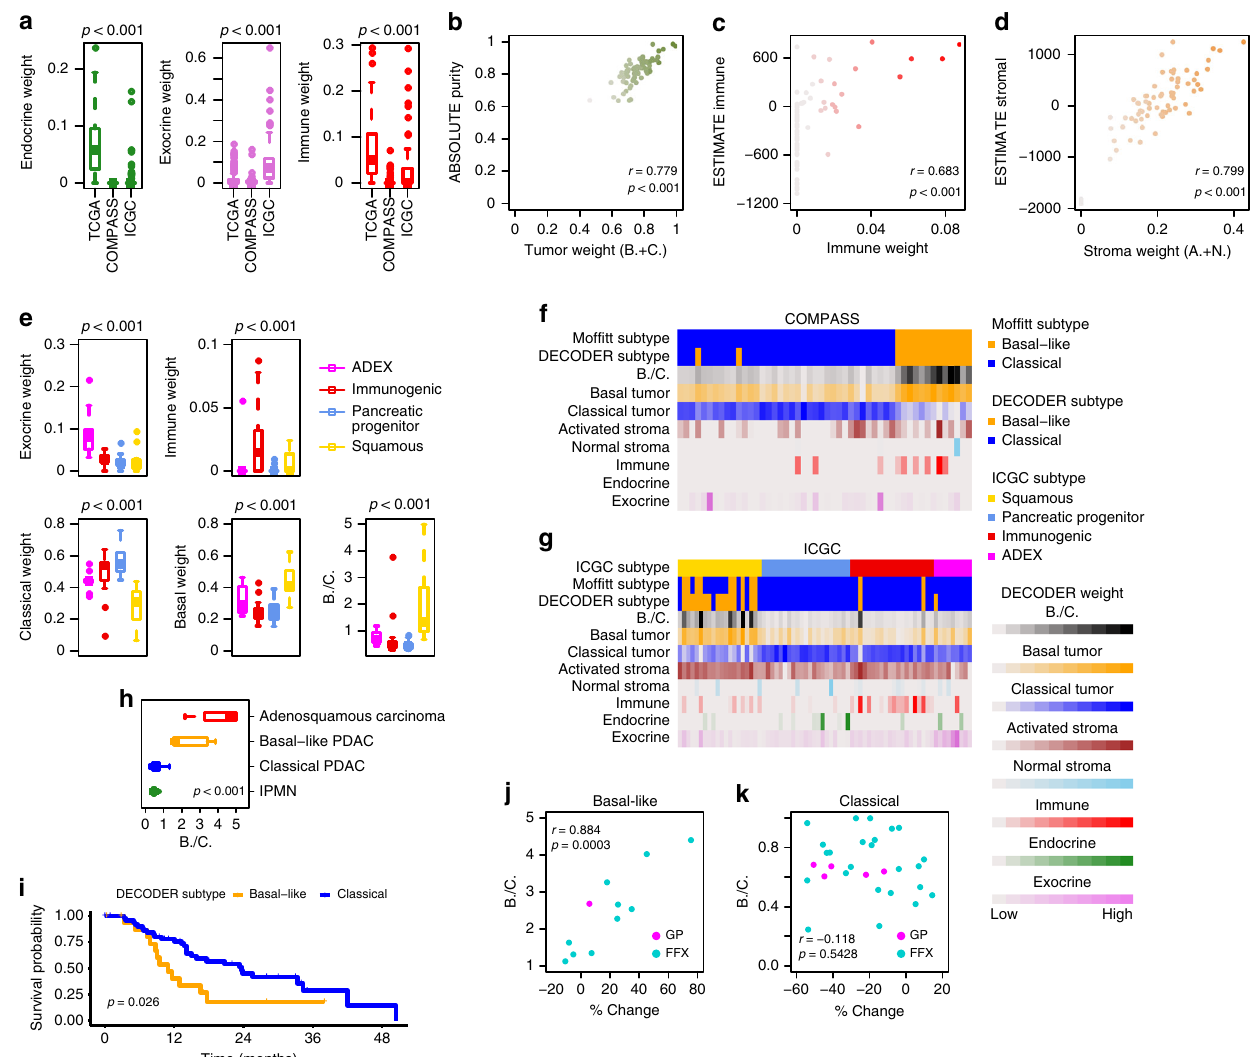
Fig. 3 Single-sample compartment weight estimation in COMPASS and ICGC PACA-AU RNA-seq data set. a Endocrine, exocrine, and immune weights in the COMPASS (microdissected), ICGC (PACA-AU), and TCGA (PAAD) data sets (Kruskal – Wallis test). b – d Correlations of DECODER estimated tumor weight (the sum of basal tumor and classical tumor weights), immune weight, and stroma weight (the sum of activated stroma and normal stroma weights) with ABSOLUTE tumor purity (Pearson correlation), ESTIMATE immune score (Spearman correlation), and ESTIMATE stromal score (Spearman correlation), respectively. e Exocrine, immune, classical tumor, and basal tumor weights for the ICGC-subtyped ADEX, Immunogenic, Pancreatic Progenitor, and Squamous samples in the ICGC PACA-AU RNA-seq data set (Kruskal – Wallis test). f , g Associations of compartment weights with the tumor subtype calls. Colored tracks show compartment weights, the ratio between basal tumor and classical tumor weights (B./C.), tumor subtypes called by B./C. (DECODER subtype), tumor subtypes called by the clustering-based Mof fi tt schema (Mof fi tt subtype) and subtypes called by ICGC (ICGC subtype). For COMPASS, samples are ordered by consensus clustering using 50 Mof fi tt tumor exemplar genes. For ICGC, samples are ordered by ICGC subtypes. h B./C. for ICGC samples grouped by intraductal papillary mucinous neoplasm (IPMN), Classical PDAC, Basal-like PDAC and adenosquamous carcinoma (Kruskal – Wallis test). i Kaplan – Meier plot of DECODER subtypes in the ICGC data set (Log-rank test). Patients with B./C. > = 1 were categorized as Basal-like, while those with B./C. < 1 as Classical. j , k Correlations of the percent change (% change) in size of tumor target lesions from baseline, with B./C. in DECODER Basal-like and Classical samples (Pearson correlation). One Basal-like sample with an unstable DNA subtype was removed. Treatment of gemcitabine plus nab-paclitaxel (GP) and modi fi ed-FOLFIRINOX (FFX) was colored, respectively. Box plots in a , e , h show the median (center line) and interquartile range (box), with whiskers denoting 1.5 times the interquartile range above and below the upper and lower data sets (Fig. 3a). In the ICGC data set ( n = 70), similar to our accurately capture the biological composition of a sample. In TCGA PAAD results, we found that ABSOLUTE-based tumor addition, the ICGC-subtyped ADEX samples ( n = 9) are asso- purity, ESTIMATE-based immune and stromal scores correlate ciated with higher exocrine weights, and the immunogenic with respective compartment weights derived by DECODER samples ( n = 20) are associated with higher immune weights (Fig. 3b – d). For the two acinar cell carcinoma samples in this data (Fig. 3e). These results may suggest that ADEX and Immunogenic set, we found that the exocrine weights were 4.78-fold and 6.96- samples are characterized by an overrepresentation of exocrine fold higher than the mean of the exocrine weights in all other and immune cells in the respective samples, which may confound samples. This suggests that the calculated DECODER weights can the identi fi cation of tumor-speci fi c subtypes 19,25 .